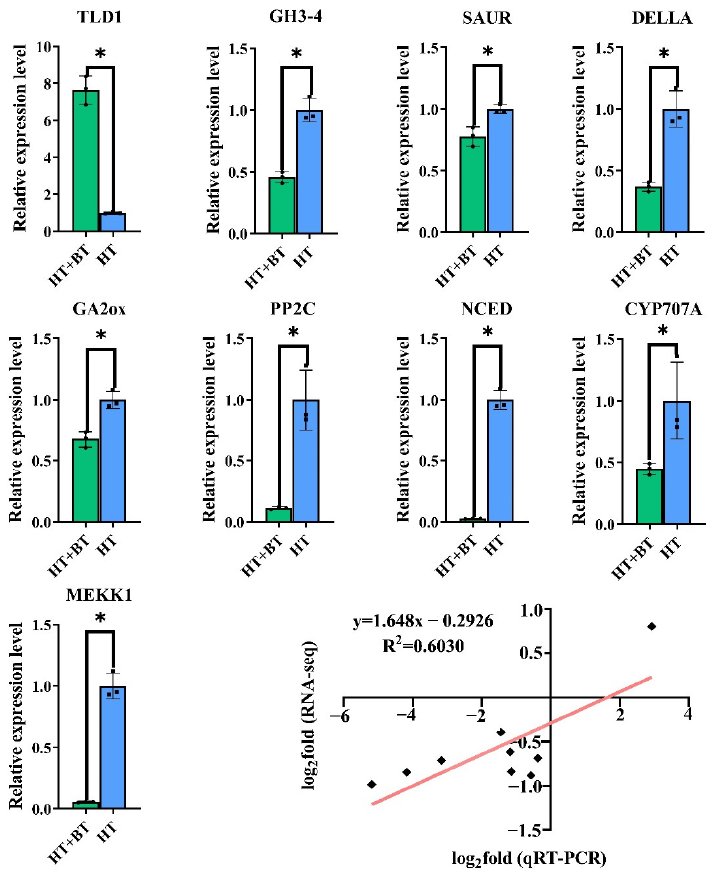
Figure 8. The expressions of 9 differentially expressed genes in the H 2 O 2 pathway and 3 endogenous hormone pathways were randomly verified by qRT-PCR. The x-axis is the name of the treatment, in which HT is the 38 ◦ C non-soaking treatment, and HT + BT is the 38 ◦ C betaine seed-soaking treatment. The y-axis shows the relative expression of a specific gene relative to the reference gene actin. The last panel shows the results of the RNA-seq \ qRT-PCR correlation analysis (lower right corner). The x-axis is the log 2 -fold-change value of the qRT-PCR, and the y-axis is the log 2 -fold- change value of the RNA-seq. According to the Pearson correlation ( R 2 = 0.60; p < 0.05), there is a significant positive correlation between the multiple changes in expression. Each parameter * indicates significant statistical difference, * ( p <